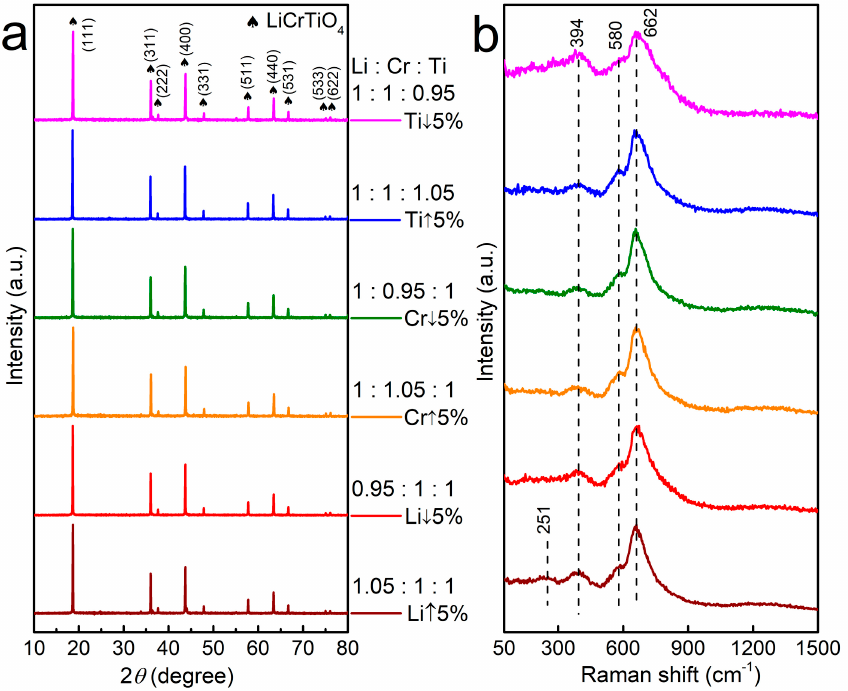
Figure 5. ( a ) The XRD patterns and ( b ) the Raman spectra of LiCrTiO 4 sintered in a powder form at a temperature of 850 °C with an elemental ratio of Li:Cr:Ti as1.05:1:1 (wine), 0.95:1:1 (red), 1:1.05:1